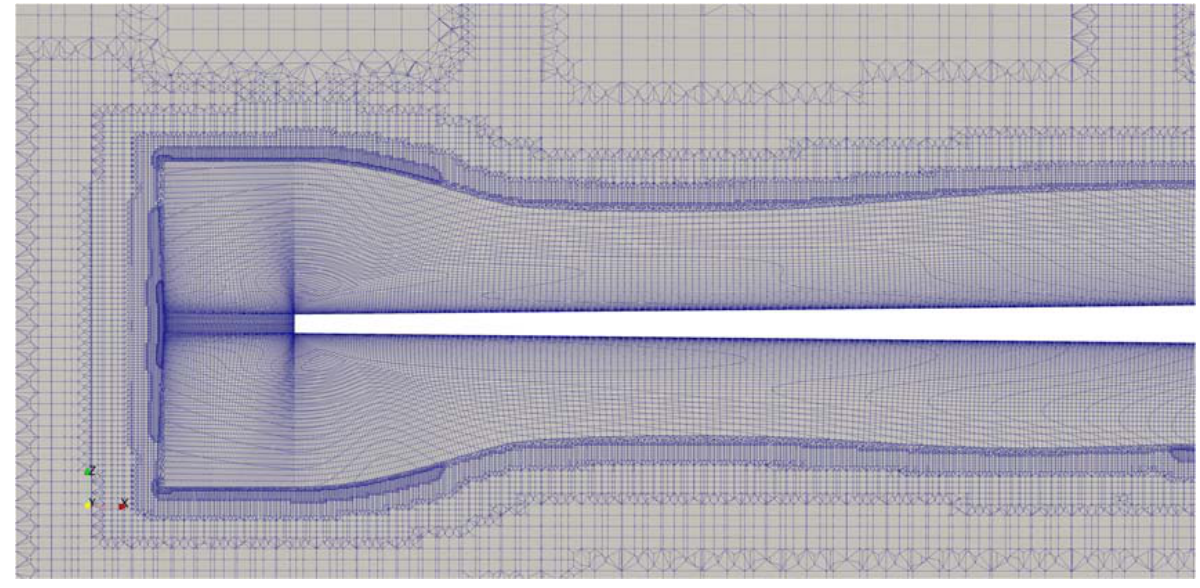
Figure 9. Hyperbolic boundary layers of the NREL Phase VI wind turbine (top view).